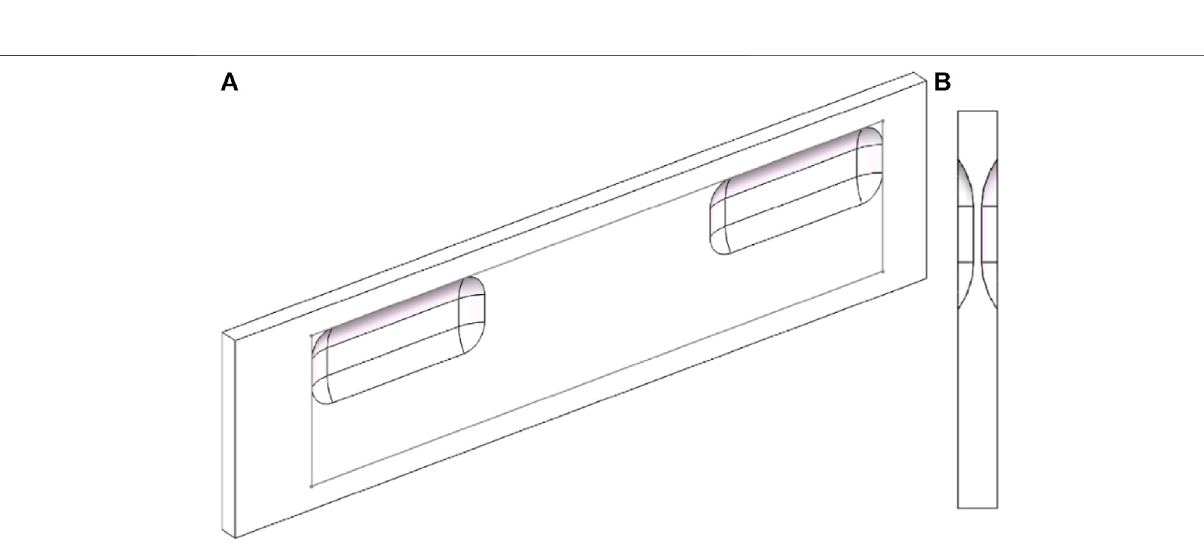
FIGURE 2 | The geometric model of pillow blisters. (A) Global geometric (B) Cross